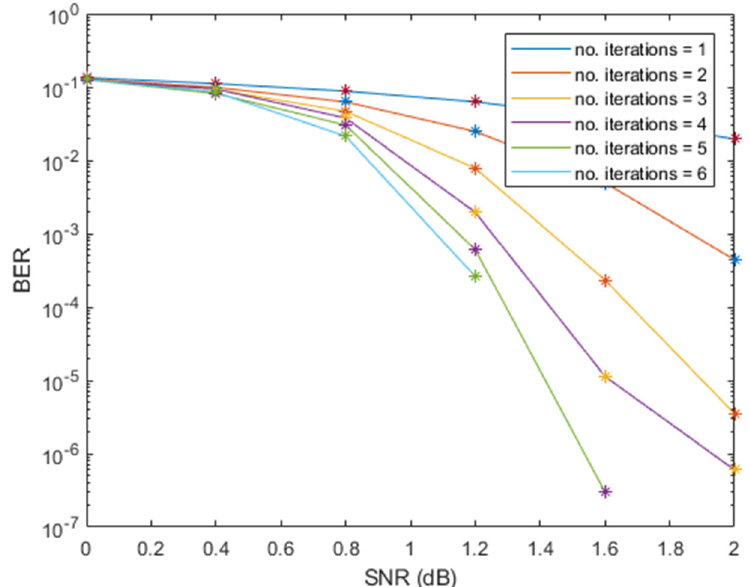
Figure 4. BER performance of Turbo decoding using ∆ f n = 15 kHz.